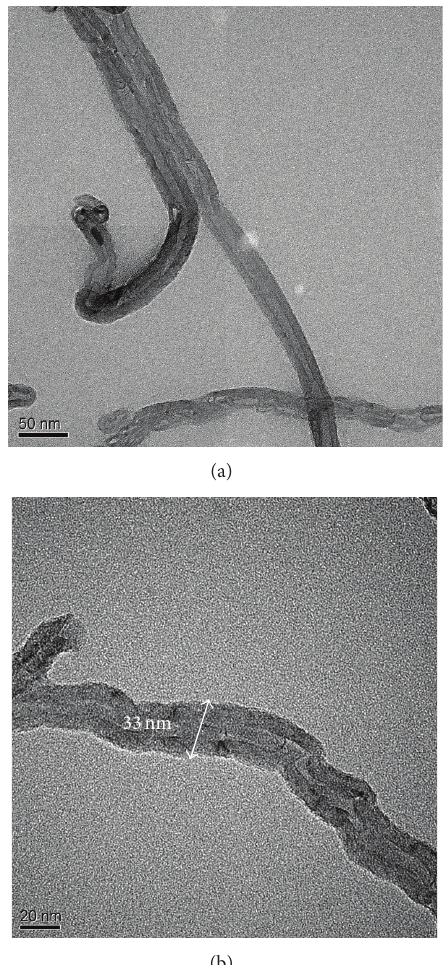
Figure 4: The TEM images of liquid-like MWNTs nanofluids.